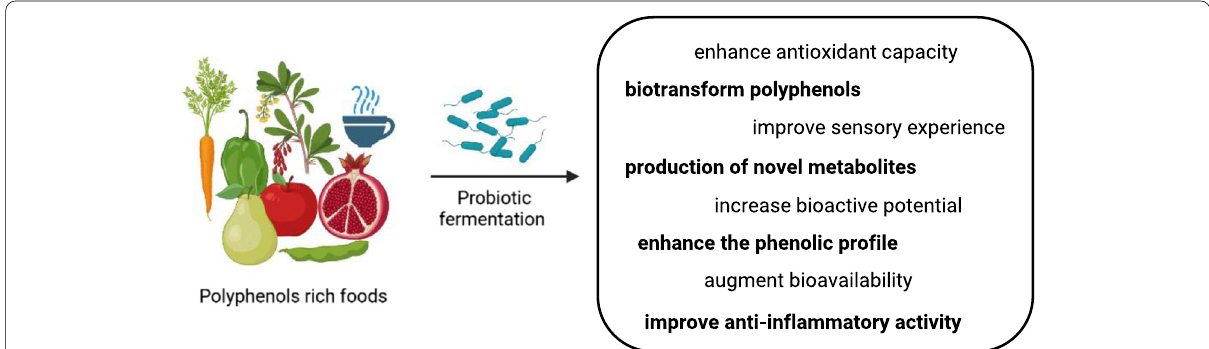
Fig. 2 Effect of fermentation with probiotic bacteria on qualitative and quantitative changes in polyphenols present in various